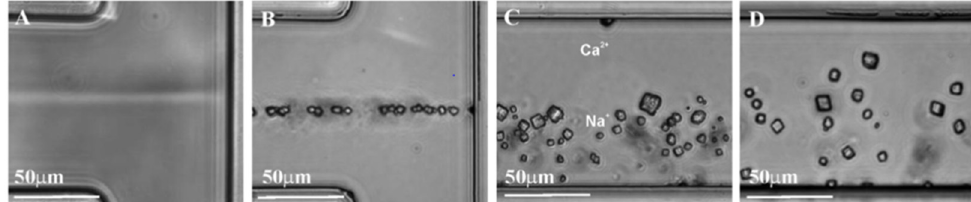
Figure 1. CaCO 3 crystal formation in laminar flow after mixing Na 2 CO 3 and CaCl 2 solutions in deionized water: ( A ) initial flow cell; ( B ) formation of the crystals at the interface of the salts; ( C ) crystal formation on the CO 32 − side of the stream; and ( D ) uniform distribution of crystals over that laminar flow. Image reproduced from Huabing Yin et al., with permission from Anal. Chem. [30].